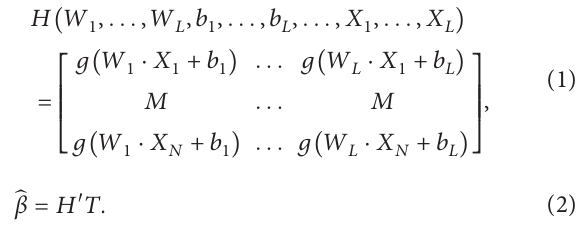
Algorithm 4. First, the historical trajectory vector F and the future trajectory vector T of the nodes and the number of hidden layer nodes L are obtained in a dynamic environ- ment. Then the hidden layer node parameters are w i and b i (lines 1-2). Then calculate the hidden layer node output matrix H according to F (line 3). Then calculate the pa- return the parameters.